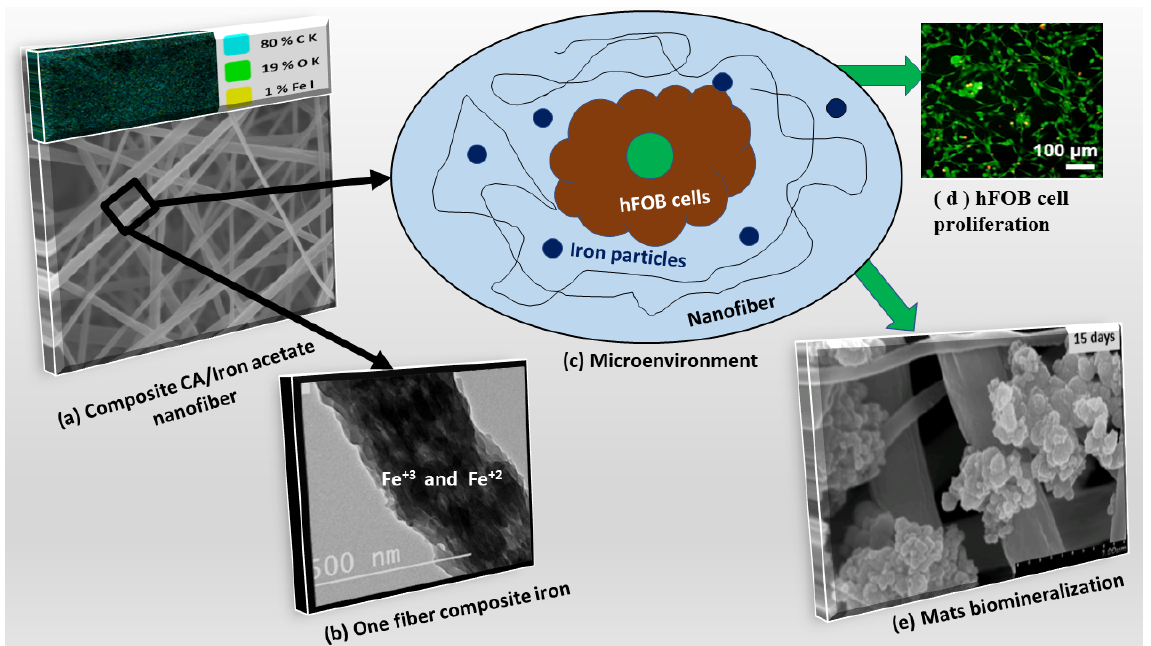
Figure 10. Scheme of composite mats and the microenvironment: ( a ) mat morphology with elements map distribution, ( b ) TEM image of fiber and iron nanoparticles distribution, ( c ) microenvironment and interaction with nanofiber mats, ( d ) hFOB cell proliferation, and ( e ) apatite formation after 15 days of incubation in a similar microenvironment.